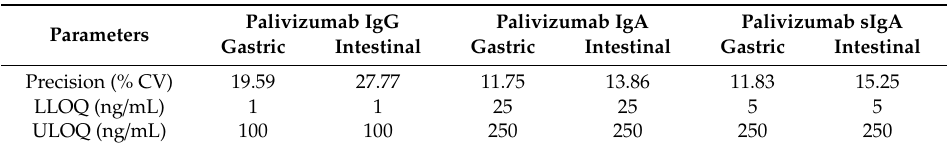
Table 2. Validation of RSV (respiratory syncytial virus) F protein-specific palivizumab IgG, IgA, and sIgA using the calculation of precision, lower limit of quantification (LLOQ), and upper limit of quantification